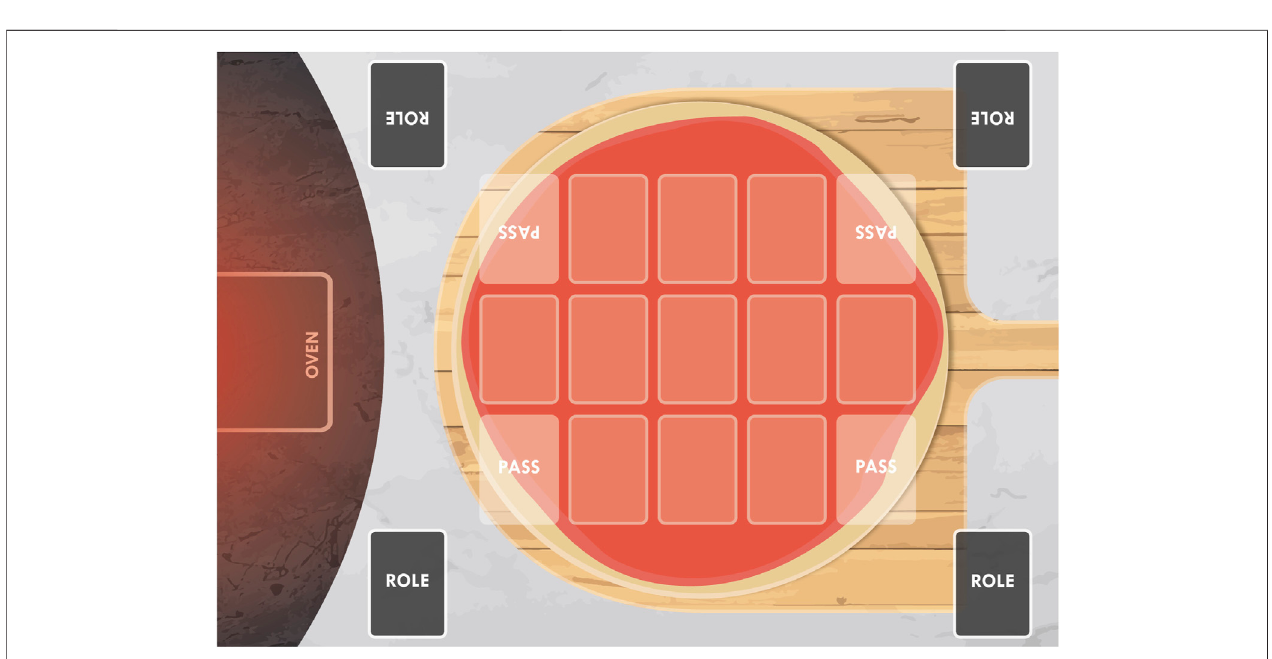
FIGURE 3 | Playing fi eld where the cards are placed, representing a pizza board.